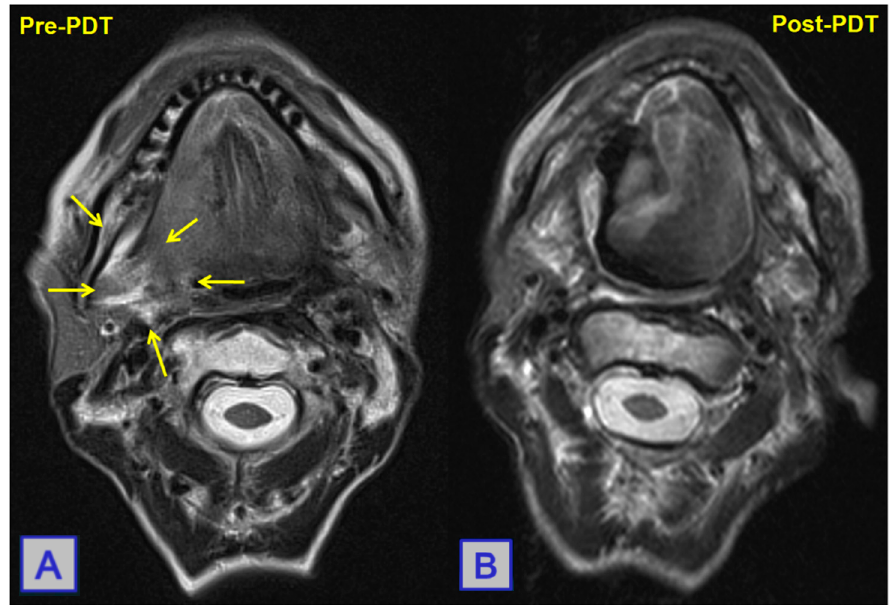
Figure 11. MRI showing a posterolateral tongue-base squamous cell carcinoma. Pre-PDT ( A ), a large mass is seen. Post-PDT ( B ), a reduction in lesion size with widespread tumour necrosis is noted. Reprinted with permission from ref. [10]. Copyright 2010 Clin. Oncol. (R. Coll. Radiol.).